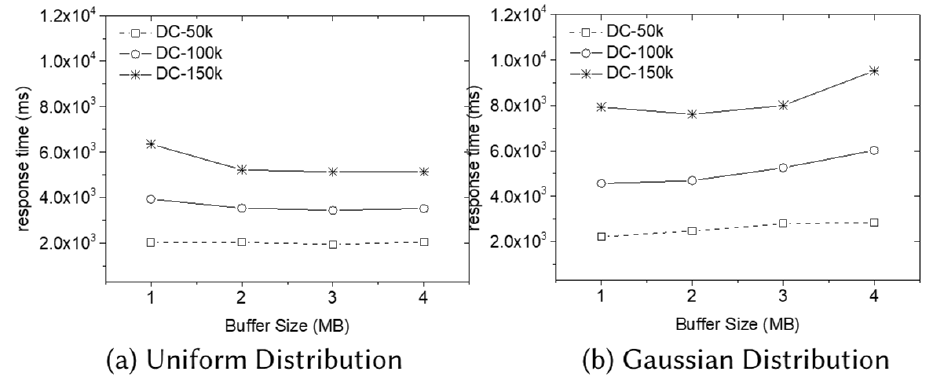
Figure 13. Results related to the I/O in 3D